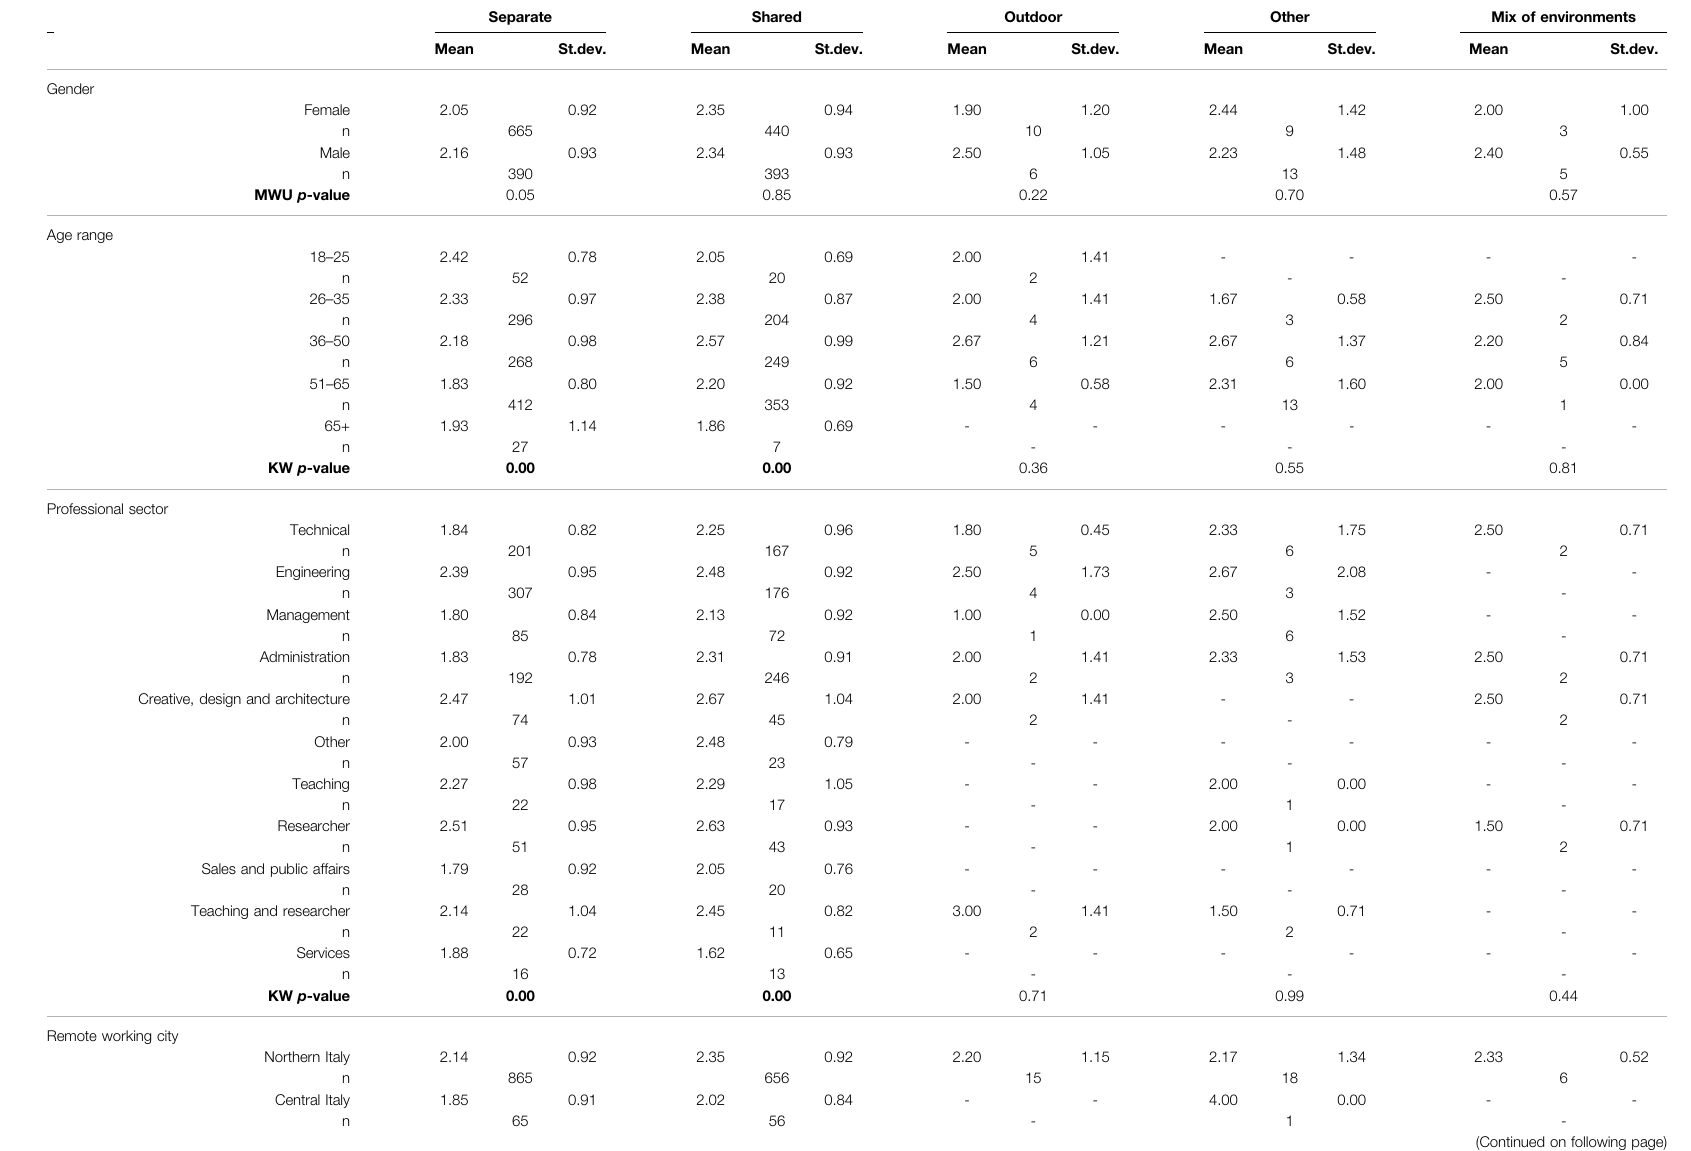
TABLE 6 | Mean and standard deviation (St.dev.) values of the answers on noise annoyance (Q1) related to gender, age range, professional sector, and remote working city for different types of environment of the overall sample ( n (cid:1) 1934). Two-tailed p -values of signi fi cance of the differences according to the Mann Whitney U (MWU) or Kruskal Wallis (KW) Test are reported. Statistically signi fi cant differences with p -values < 0.05 are reported in bold. Separate Shared Outdoor Other Mix of environments Mean St.dev. Mean St.dev. Mean St.dev. Mean St.dev. Mean St.dev.